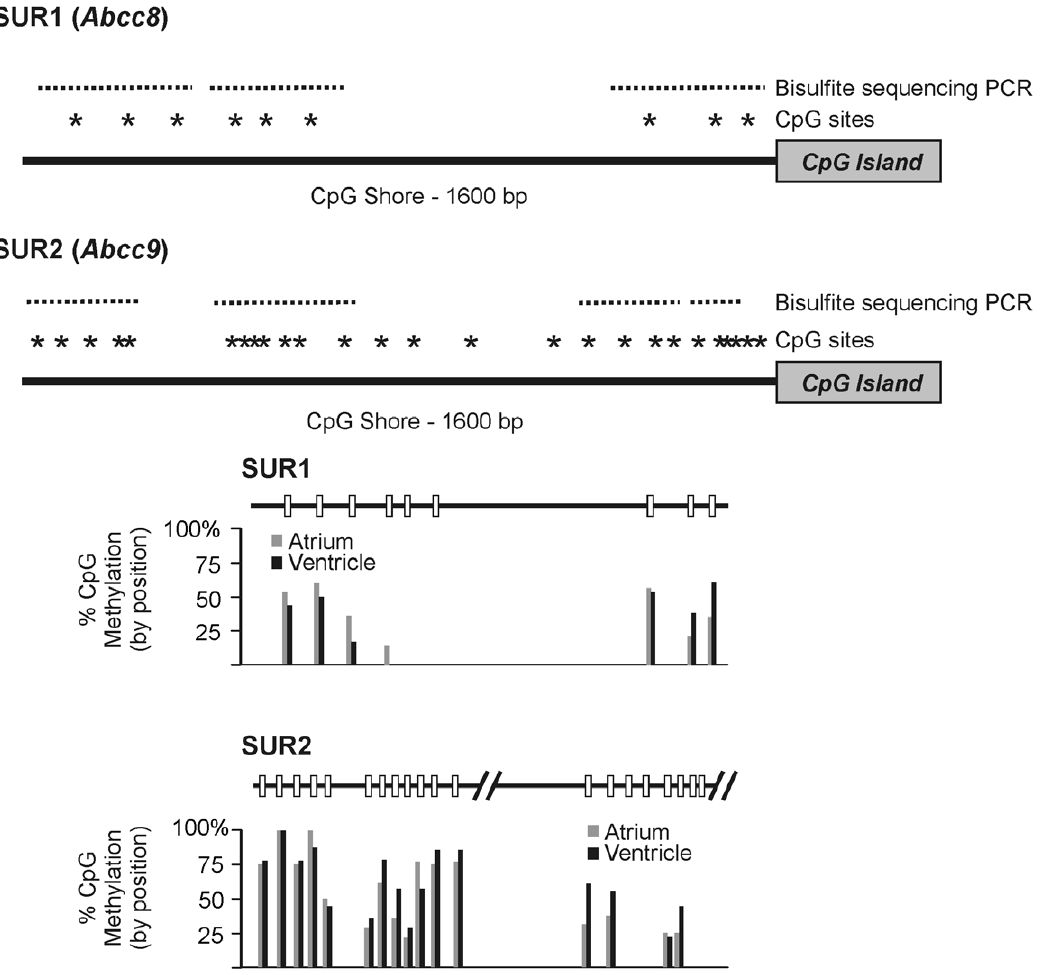
Figure 7. Chamber-specific SUR1 and SUR2 expression does not correlate with CpG shore methylation. ( A ) Cartoon illustrating the CpG shore regions comprised of , 1600 bp upstream of the CpG islands of the SUR1 and SUR2 genes. CpG dinucleotides ( asterisks ) and specific regions analyzed by bisulfite sequencing are illustrated ( dashed lines ). ( B ) Percent methylation at each of the residues tested is shown. In contrast to the CpG island where no CpG tested exhibited more than 5% methylation in atrial or ventricular DNA, we observed methylation in excess of 50% at many residues in the CpG shore. As in the island, there were no apparent differences in methylation status at any of the residues tested in atrial or ventricular genomic